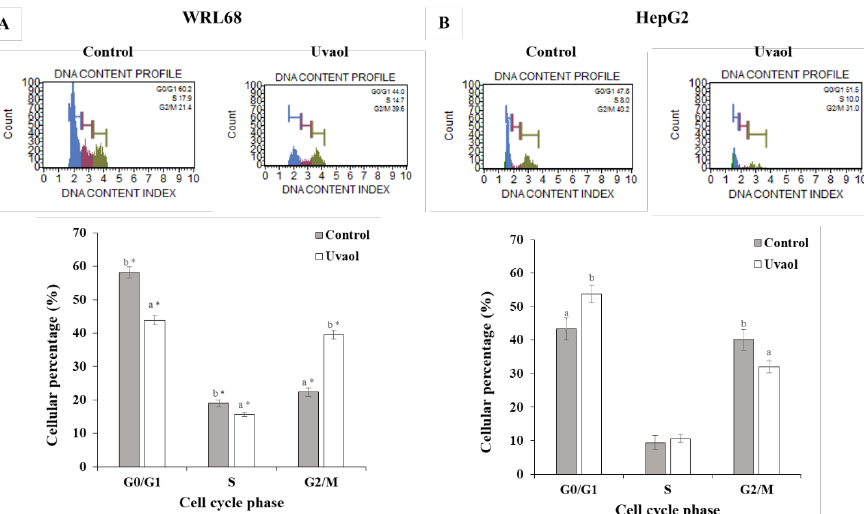
Figure 4. Cell cycle analysis obtained according to the Muse ™ cell cycle kit. Panel ( A ) correspond to WRL68 cells and panel ( B ) to HepG2 cells. The cells were treated with IC 50 of uvaol for 24 h. Top: histograms from a representative experiment show the effect of uvaol on cell cycle profile. Bottom: percentage of cells in each cellular cycle phase. Values are expressed as mean ± SEM (n = 12). Different letters indicate significant differences ( p < 0.05) between control and uvaol treatment within each phases of the cell cycle for WRL168 or HepG2 cells. The inclusion of asterisks indicates significant differences ( p < 0.05) between the different cells lines (WRL168 vs. HepG2), under the same treatment (control or uvaol) and phase of cell cycle.